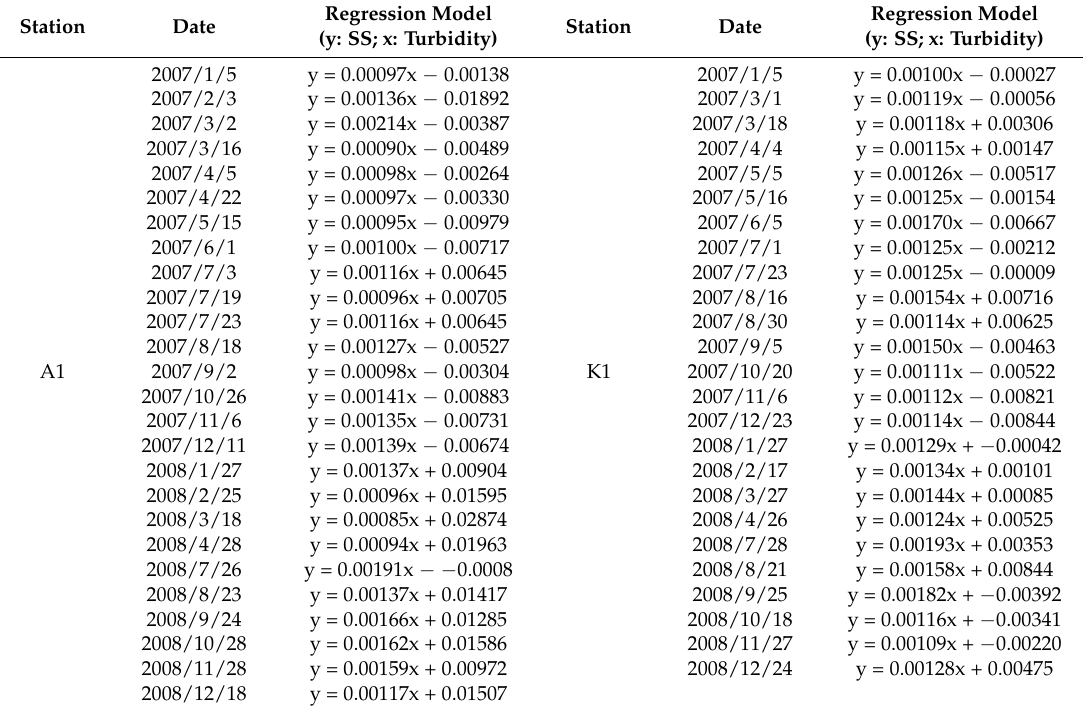
Table 1. Calibration models of OBS sensor during the field measurements. (Date format: yyyy/mm/dd). Regression Model Station Station Date (y: SS; x: Turbidity)